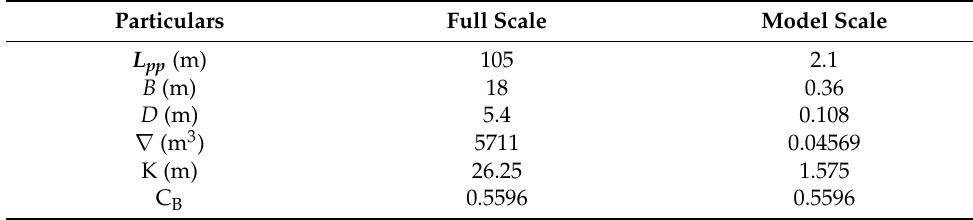
Table 2. Main particulars of “Yukun”